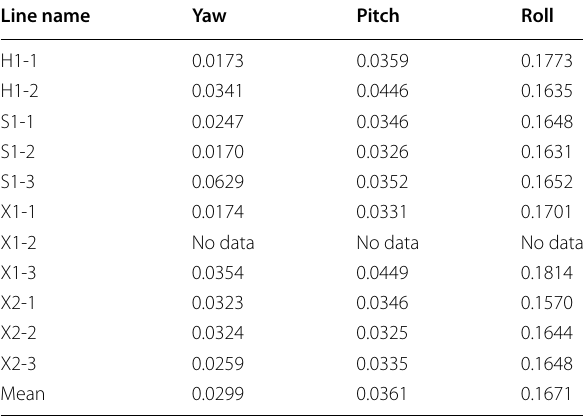
Table 5 The standard deviation of the GNSS antenna array attitude